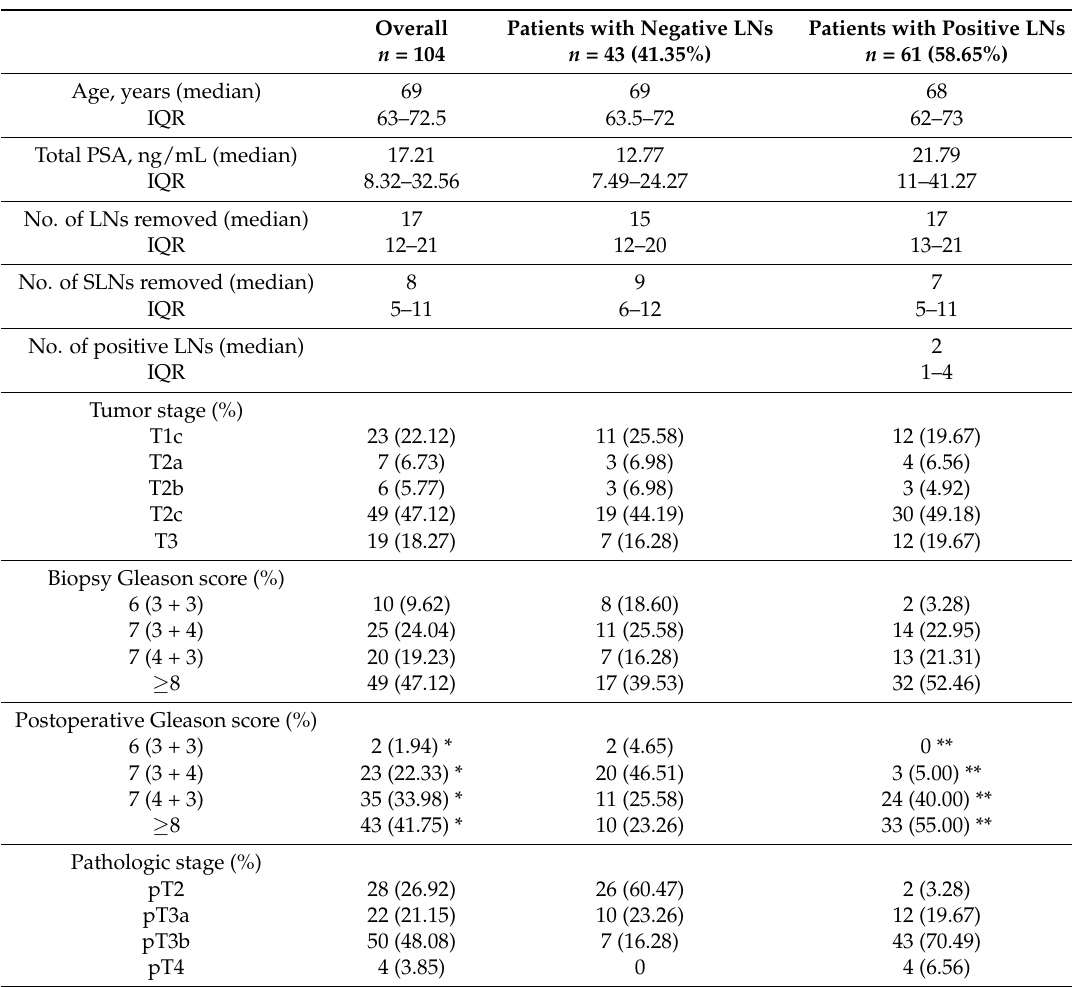
Table 1. Patient